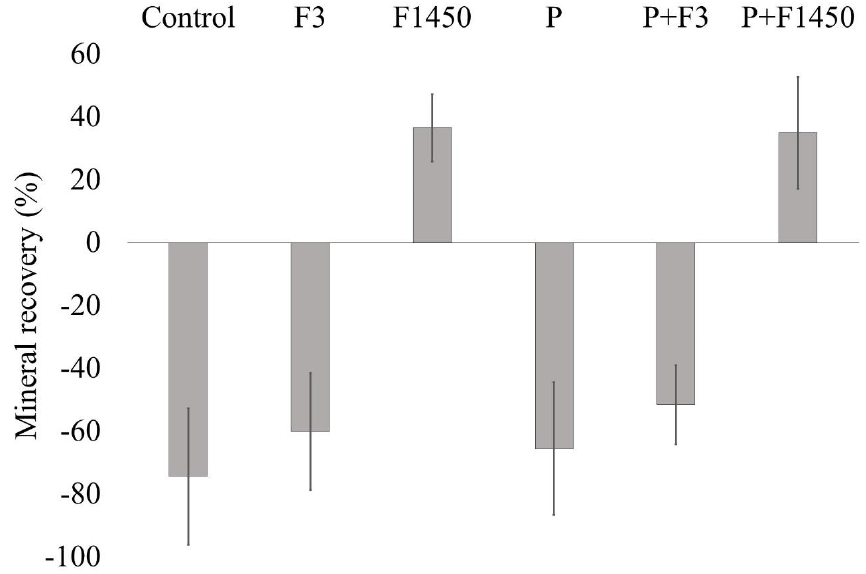
Figure 4. Mineral recovery rate of the six groups.